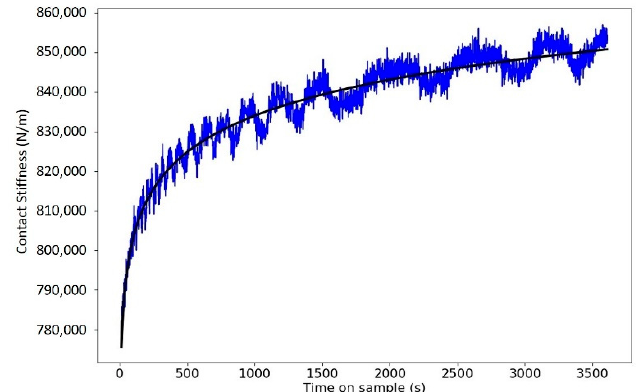
Figure 5. Plot of contact stiffness vs. time for the same test as shown in Figure 4. The contact stiffness data obtained using the CSM are shown in blue. Although these data appear to be noisy and ocsillatory, they are a more accurate measure of the deformation than the displacement data, because of their insensitivity to thermal drift. A smoothed fit to the data is shown in black, but we use the unsmoothed data in all subsequent analyses.